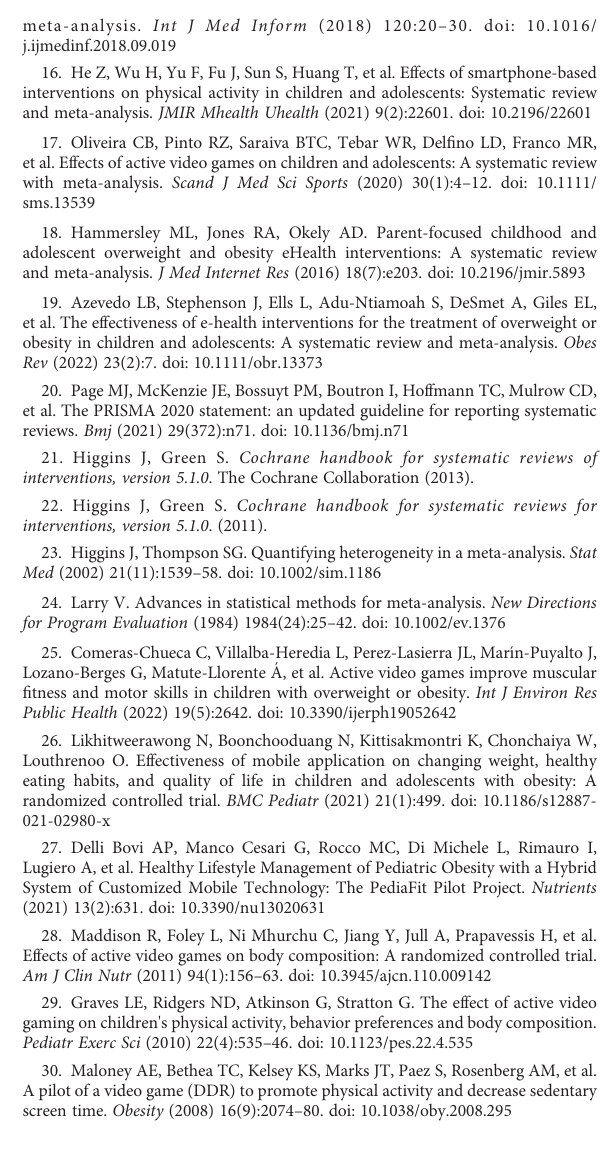
SUPPLEMENTARY FIGURE 4 Funnel plots of body mass index Z-score. SUPPLEMENTARY FIGURE 5 Funnel plots of the waist circumference. SUPPLEMENTARY FIGURE 6 Funnel plots of body